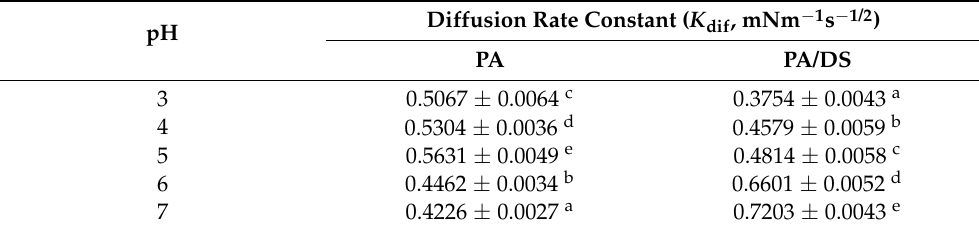
Table 1. Adsorption kinetics of PAs and PA/DS at pH 3–7 at the oil–water interface.